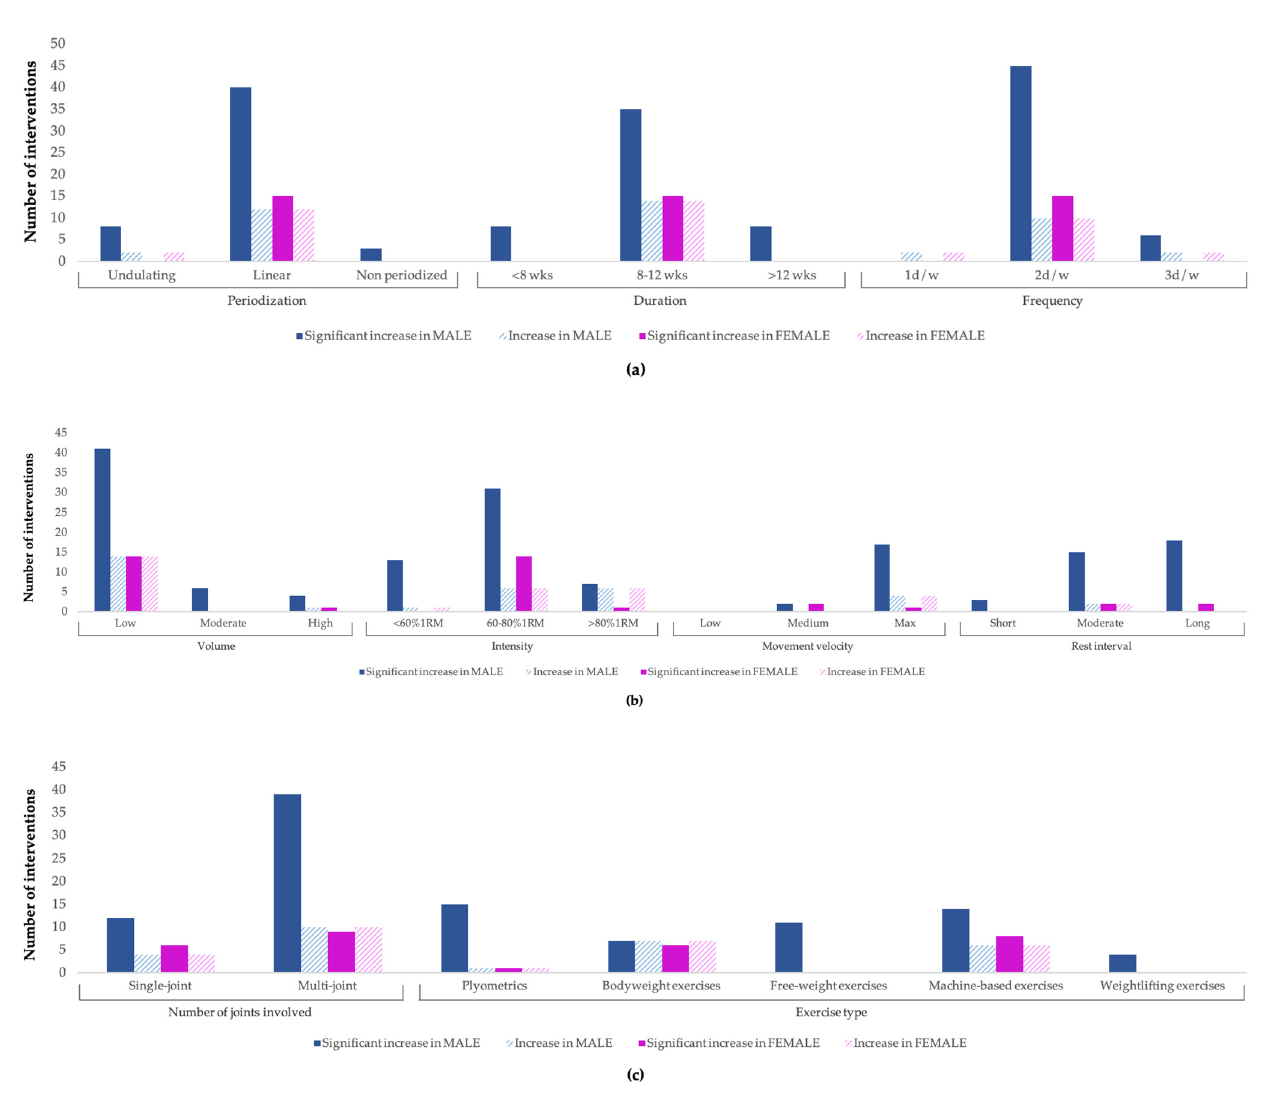
Figure 4. ( a – c ) Three ‐ block adaptation effects of STVs on muscle strength according to gender.